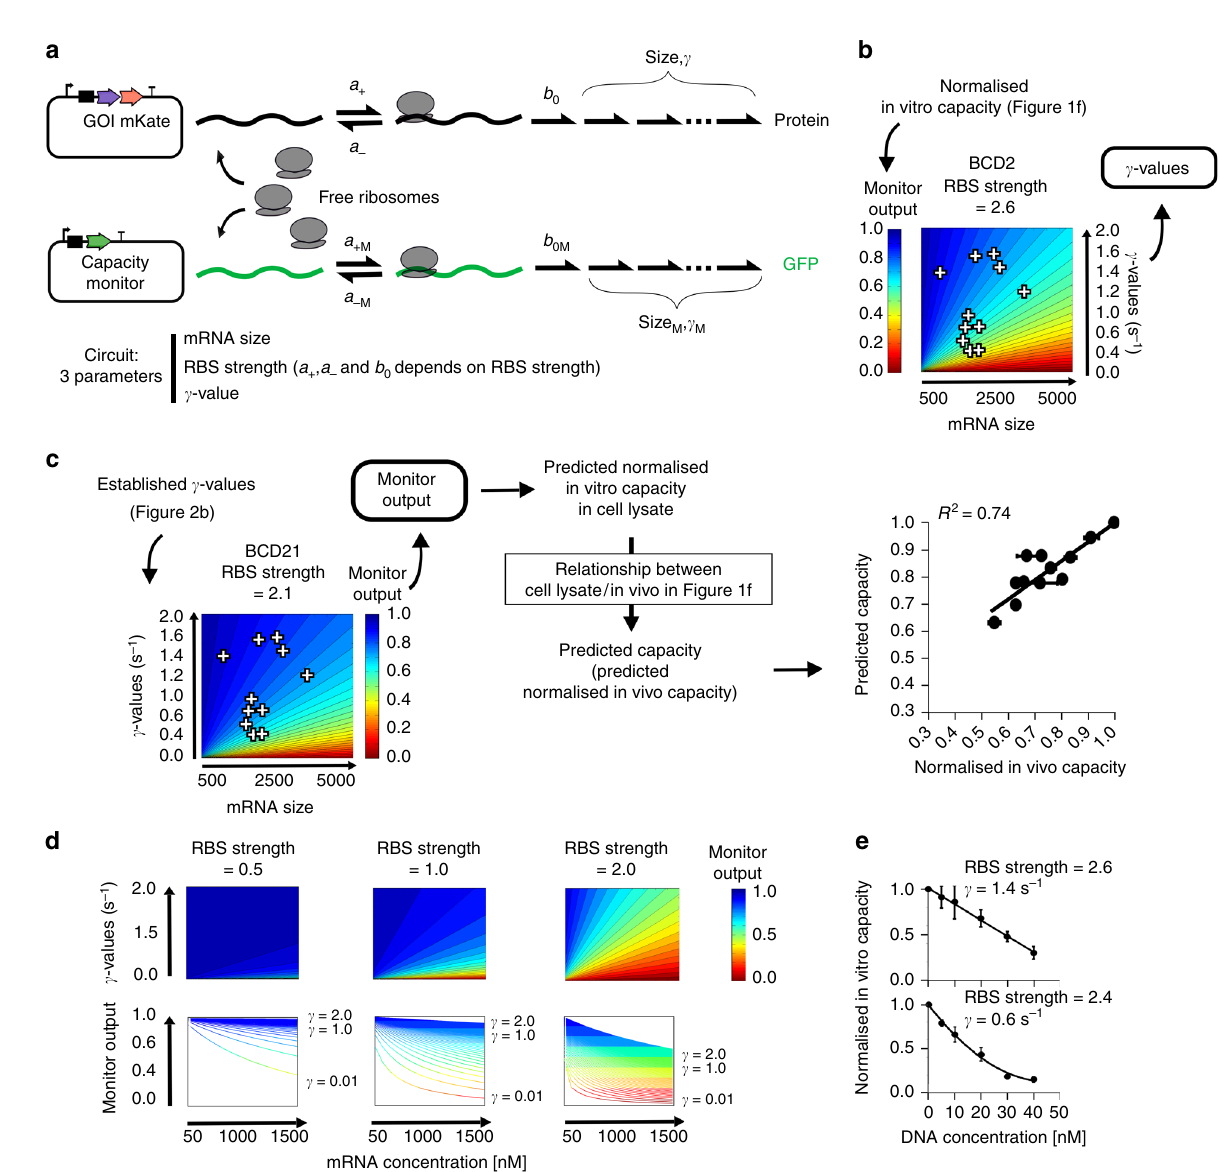
Fig. 2 Predictive model for resource competition between a synthetic construct and capacity monitor. a Schematic of mathematical model of competitive translation between capacity monitor construct and a construct expressing a GoI, with a fi nite ribosome pool. A free ribosome binds to an unoccupied RBS at a rate a + ( a + = a + M × RBS strength) and either unbinds and returns to the free ribosome pool at a rate a − ( a − = a − M /RBS strength), or initiates synthesis at a rate b 0 ( b 0 = b 0M × RBS strength). Once synthesis has initiated, all the mechanisms of the protein synthesis are gathered in the lumped parameter γ , which represents the cost of protein synthesis. The number of protein synthesis steps depends on size (mRNA size/30 — as 30 bases represents the footprint of a ribosome). Each synthesis step is considered to proceed with the same cost γ . b Heat maps of simulated capacity monitor expression (monitor output) when mRNA size and γ value of a synthetic construct are varied. The heat map is used to determine the γ value of each construct in Fig. 1f. c A new heat map simulated for weaker RBS is used to predict monitor output using γ values calculated in b . As prediction is done for cell lysate, in vivo predictions are then deduced from the relationship between cell lysate and in vivo measurements as per Fig. 1f. d First row: heat maps of simulated capacity (monitor output) when mRNA concentration and γ -values of a synthetic circuit are varied. Each heat map is a construct with different RBS strength. Second row: capacity (monitor output) as a function of mRNA level. Each line corresponds to different γ -values. e Measurements of normalised in vitro capacity when increasing synthetic construct DNA is added to cell lysate. Top: mkate with a strong RBS. Bottom: viob-mkate with a strong RBS. The calculated γ and RBS strengths (from Supplementary Fig. 4B) are shown for each construct. Lines show a fi t to data points. Error bars show standard error of three independent repeats. Values are normalised to the capacity obtained with capacity monitor plasmid